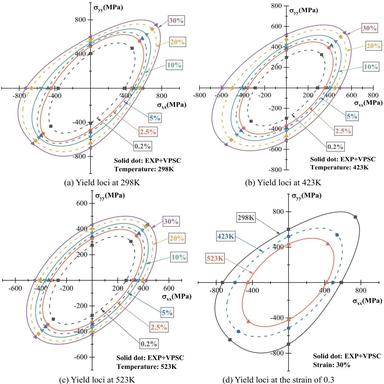
Yield loci at different temperatures and strains for the α-Ti tube. Increasing temperature reduces the anisotropy and asymmetry in terms of yield locus.